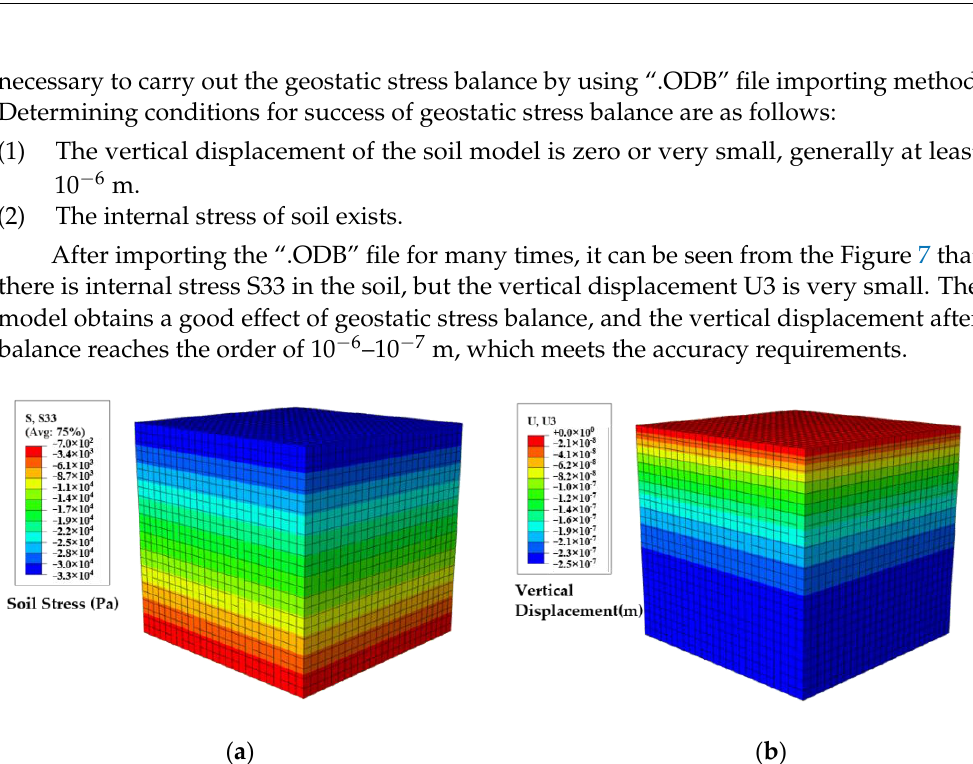
Table 7. Mesh sensitivity parameter